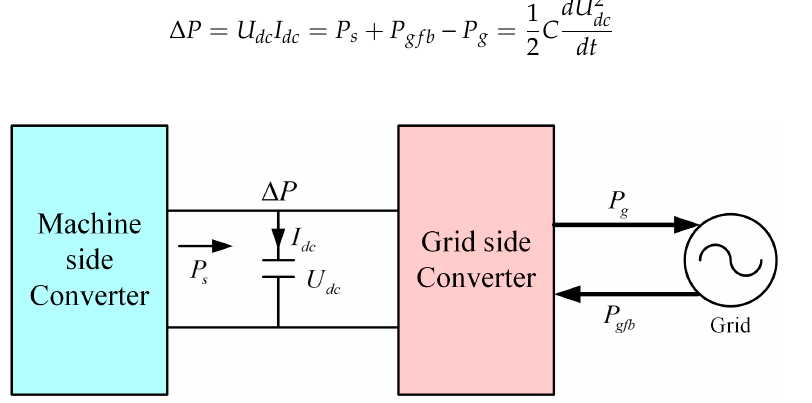
Figure 4. Schematic diagram of power balance.